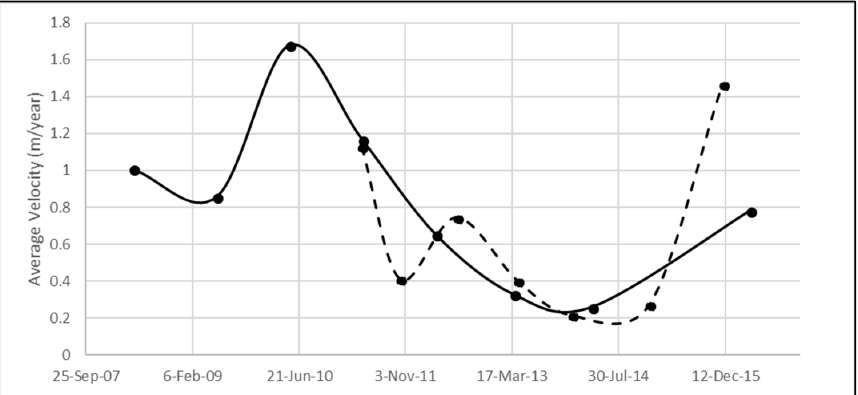
Figure 5. Average velocity time series with GPS (solid curve) and COSI-Corr (dashed curve) at GPS station UB-2 located at the toe of AcPB (the most active region of the Portuguese Bend landslide